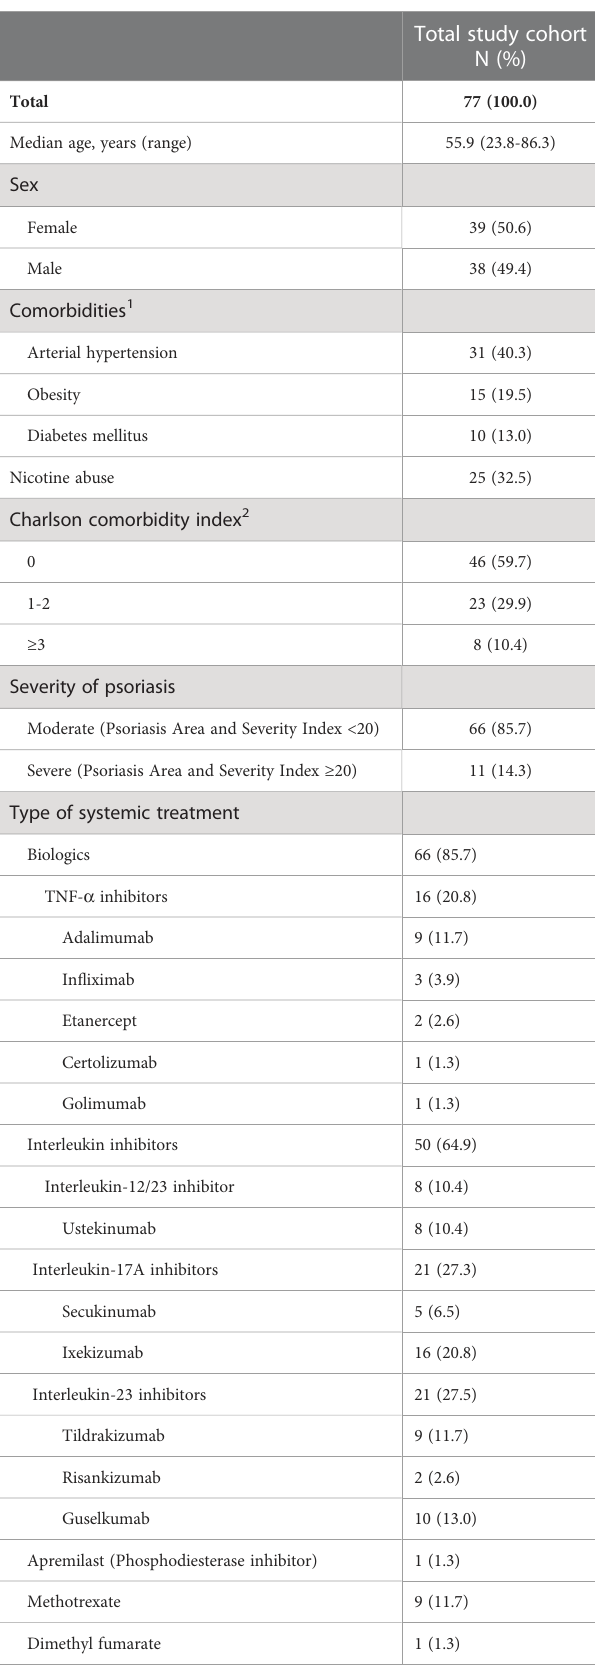
TABLE 1 Patient